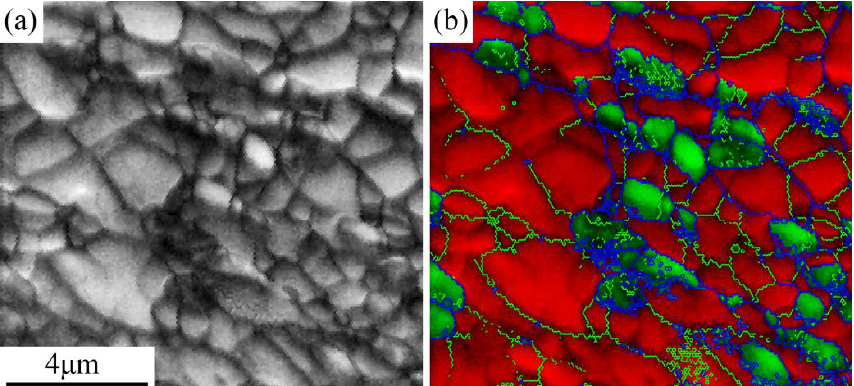
Figure 1. Microstructure of the alloy as-received: ( a ) image quality map; ( b ) grain boundary distribution plus phase map. The red field = β phase, green field = α phase, blue line = high angle grain boundaries (HAGBs, θ ≥ 15°), green line = low angle grain boundaries (LAGBs, 15° ≥ θ ≥